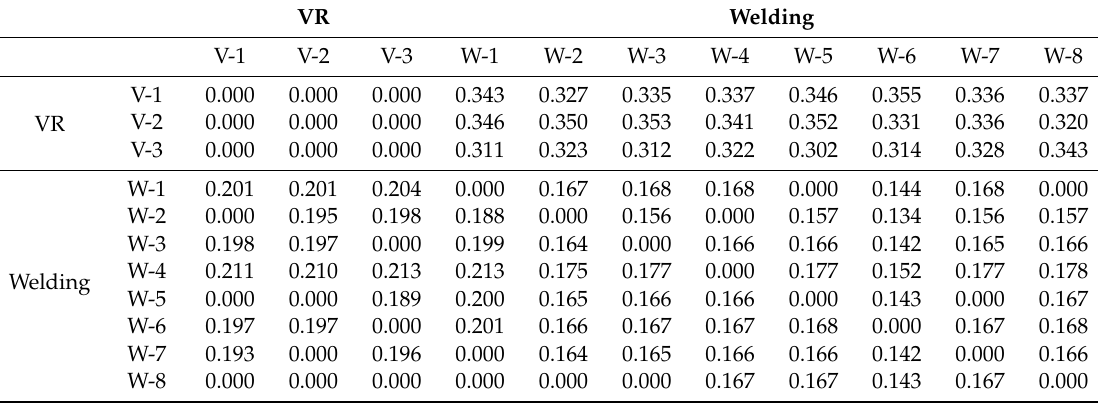
Table 5. Unweighted Supermatrix of Feasibility of VR-Assisted Welding Course Teaching.